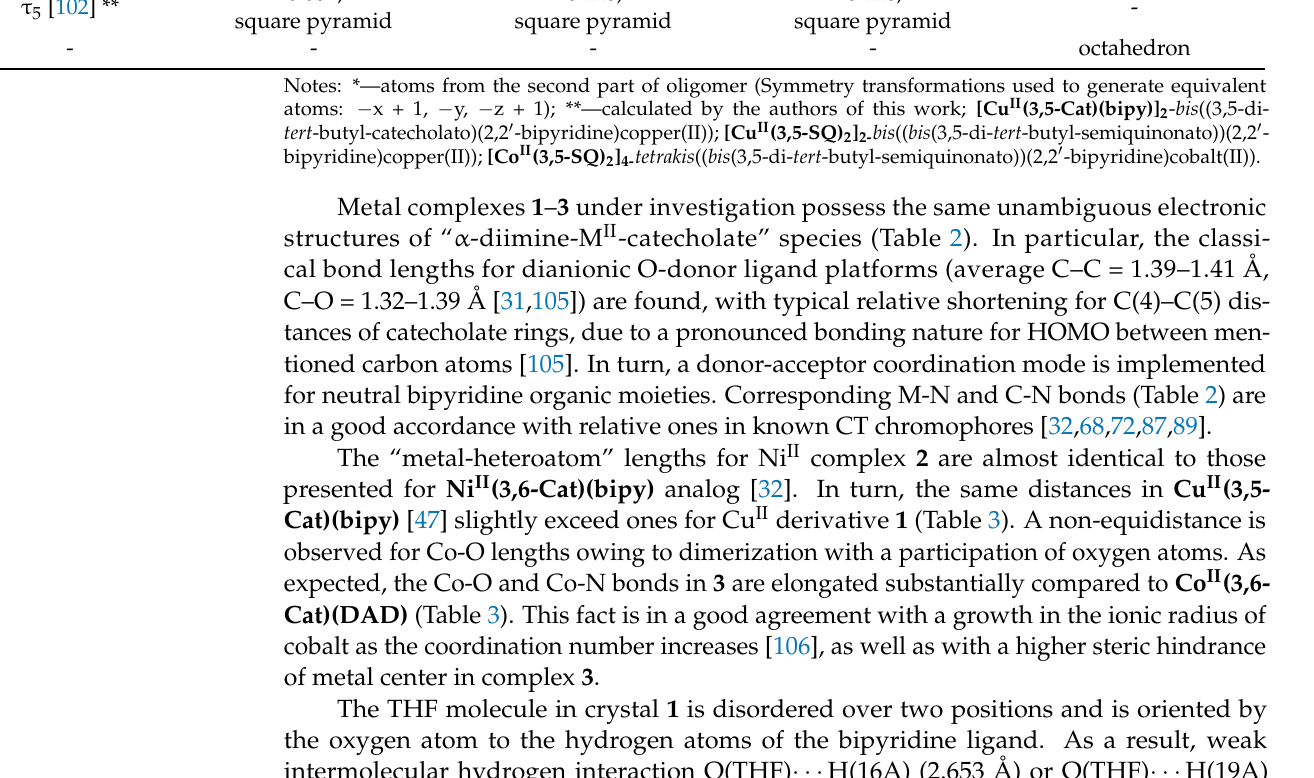
Table 1. Characteristics of a coordination polyhedron and bridging lengths for dimer 3 · toluene and reported Cu II and Co II oligomers on the base of 3,5-di- tert -butyl- o -benzoquinone type ligand. 3 ·